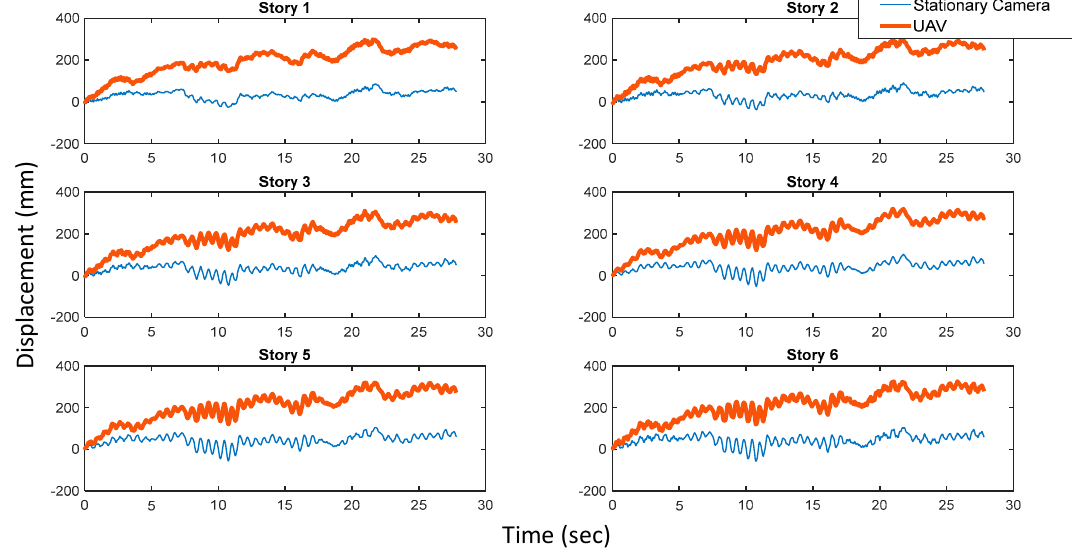
Figure 7. Comparison of absolute displacements and relative displacements.